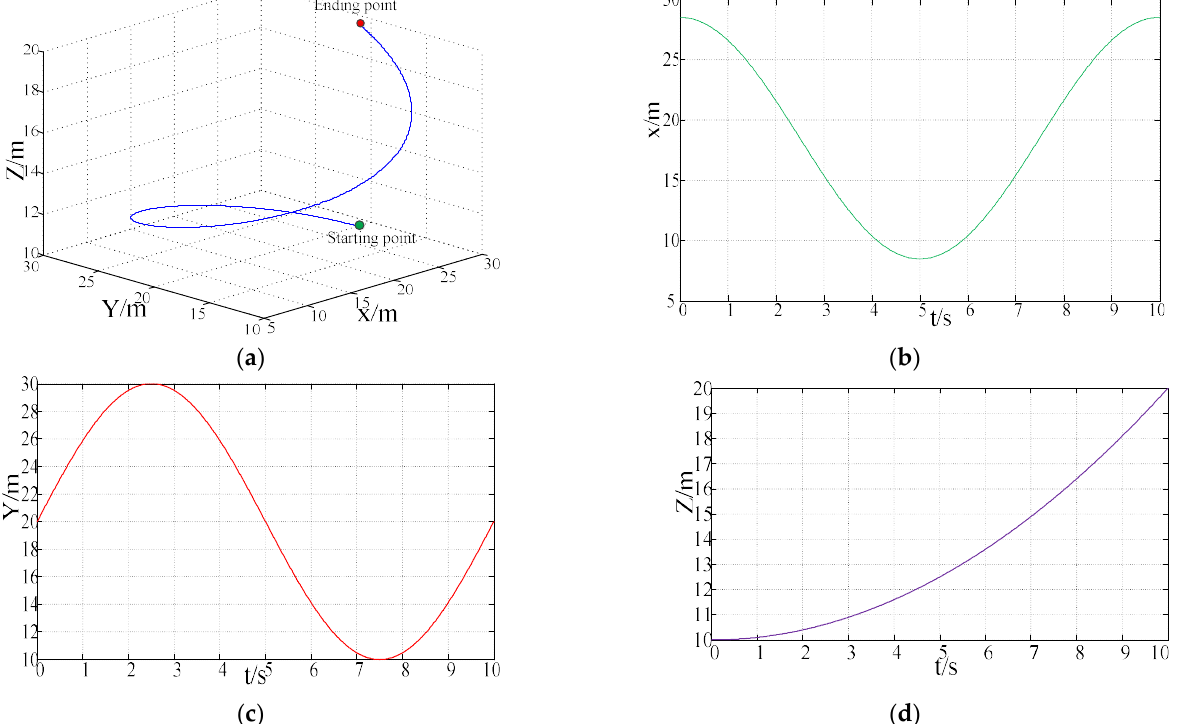
Figure 3. Spatial spiral trajectory of the camera robot: ( a ) spatial spiral trajectory; ( b ) x -component; ( c ) y -component; ( d ) z -component.